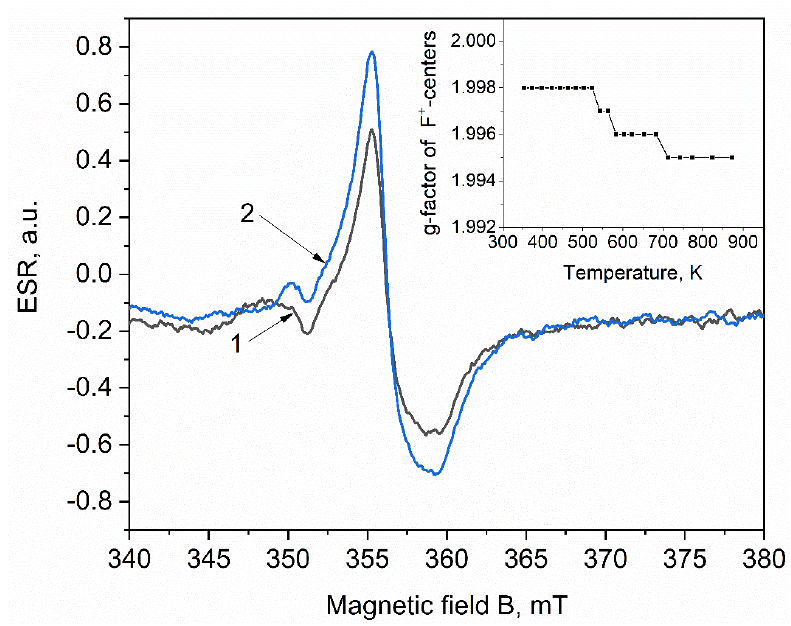
Figure 3. ESR spectra of a ZrO 2 pellet irradiated with electrons with an energy of 10 MeV, and then annealed at temperatures of 540 K (1) and 580 K (2).